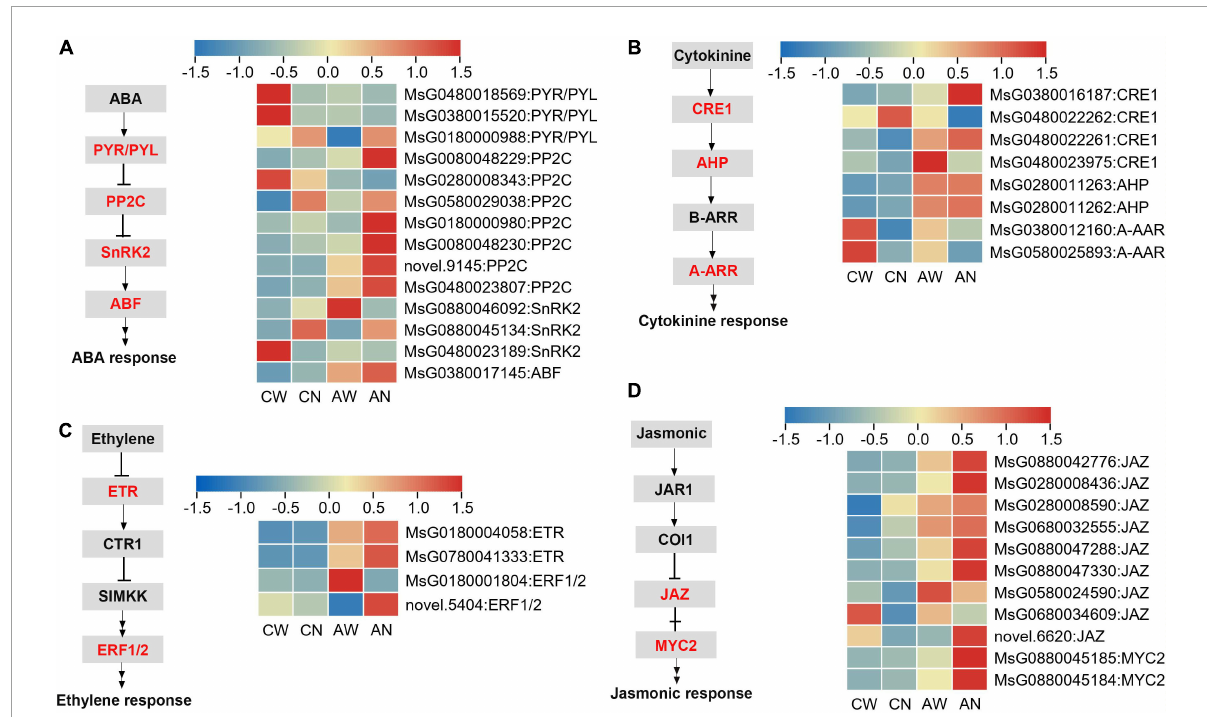
FIGURE7 Differentially expressed genes involved in plant hormone signal transduction. (A) Abscisic acid (ABA); (B) cytokinine; (C) ET and (D) jasmonic signal transduction